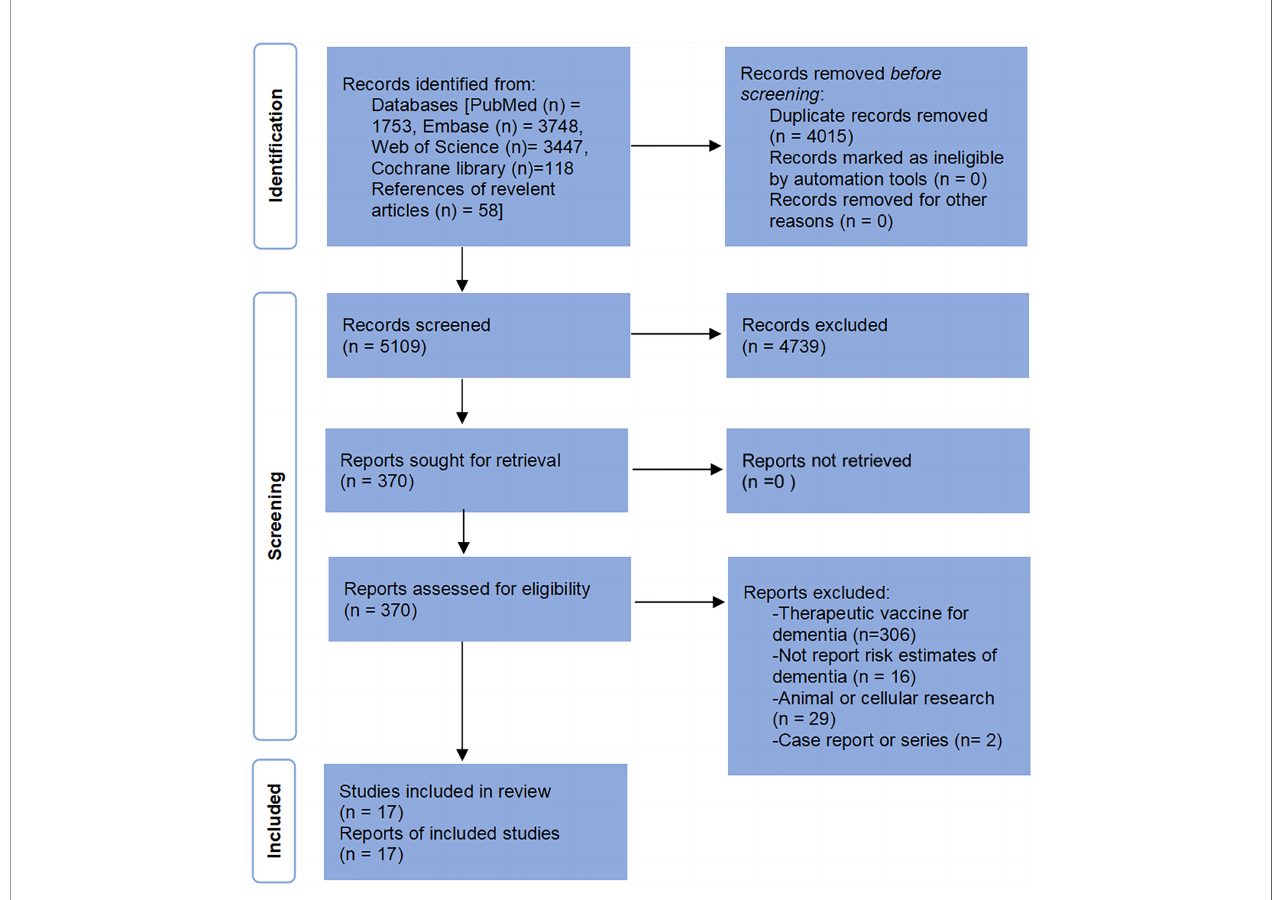
FIGURE 1 | Flow diagram of the study select